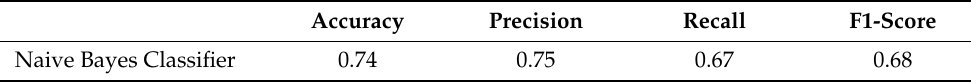
Table 2. Performance metrics of the NB classifier.